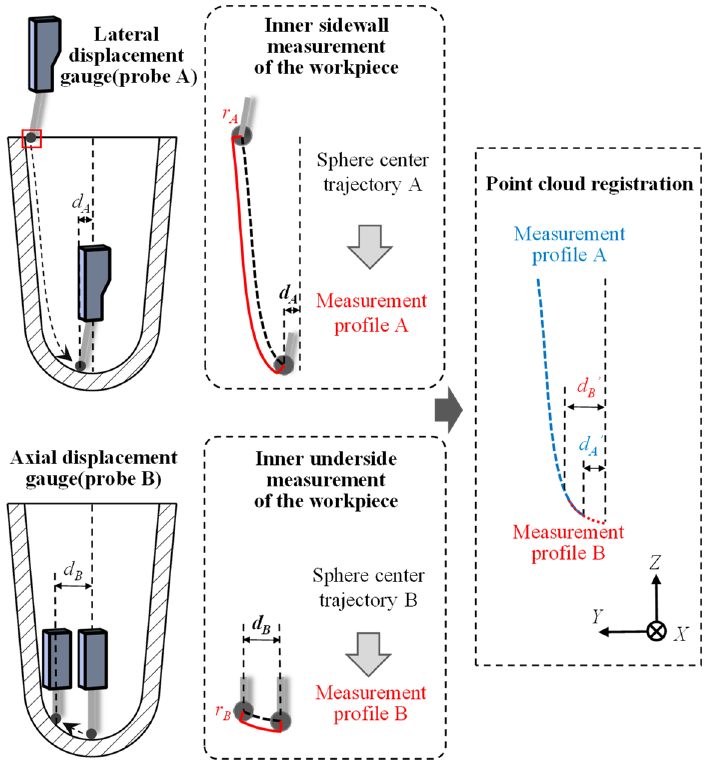
Figure 3. Measurement procedure with the two measuring probes and profile stitching.